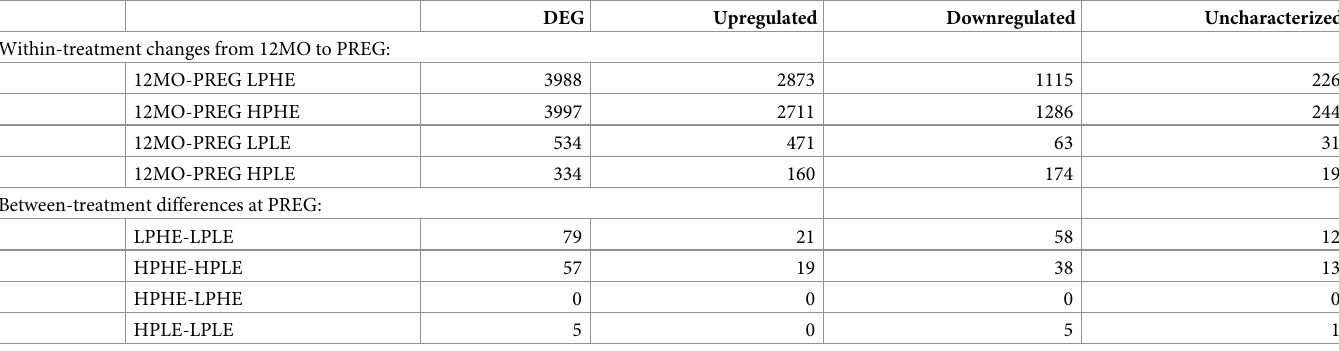
Table 3. Number of differentially expressed genes (DEG) for all examined contrasts.